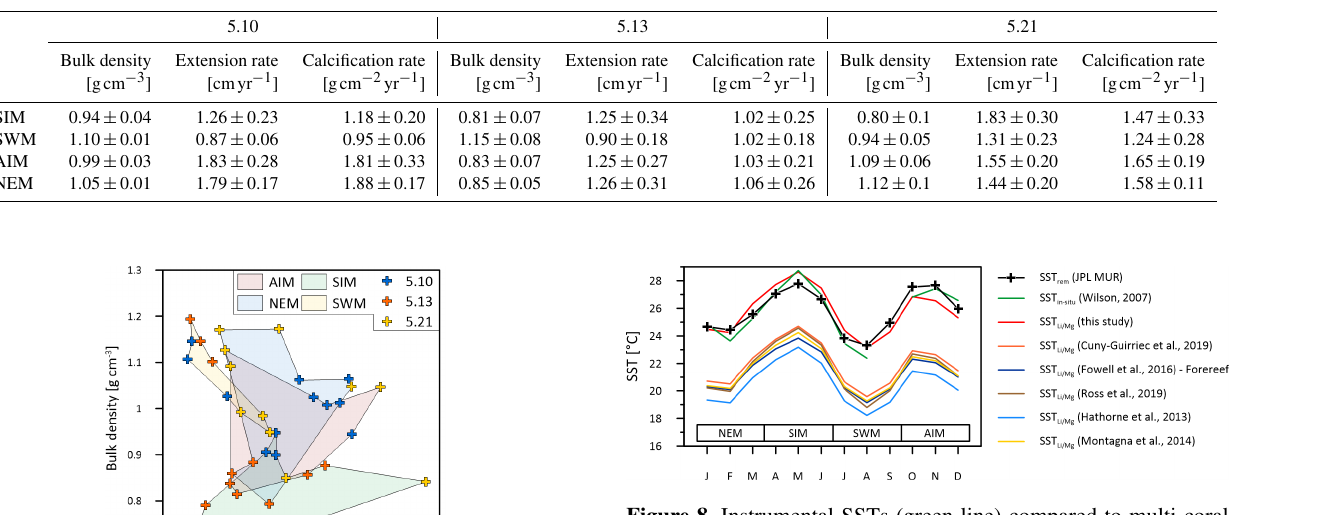
Figure 8. Instrumental SSTs (green line) compared to multi-coral monthly mean SSTs inferred from Li / Mg ratios of the Masirah corals using the calibration of this study (red line) and calibrations reported from the literature. Published Li / Mg–SST calibrations cause variable degrees of underestimation of reconstructed SST at Masirah Island. Seasonal abbreviations: NEM (northeast monsoon), SIM (spring intermonsoon), SWM (southwest monsoon), AIM (au- tumn